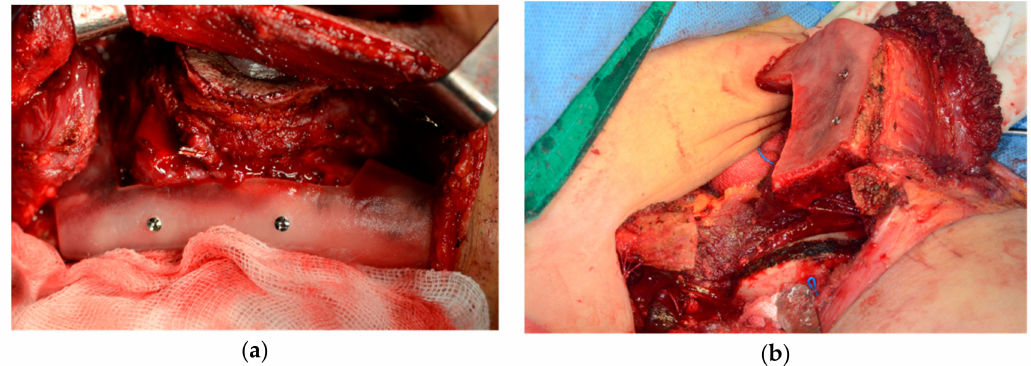
Figure 3. Intraoperative photograph: ( a ) The resection guide was applied on the mandible; ( b ) The iliac crest bone and internal oblique muscle flap was harvested using the resection